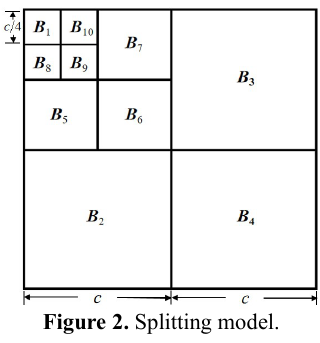
Figure 2. Splitting